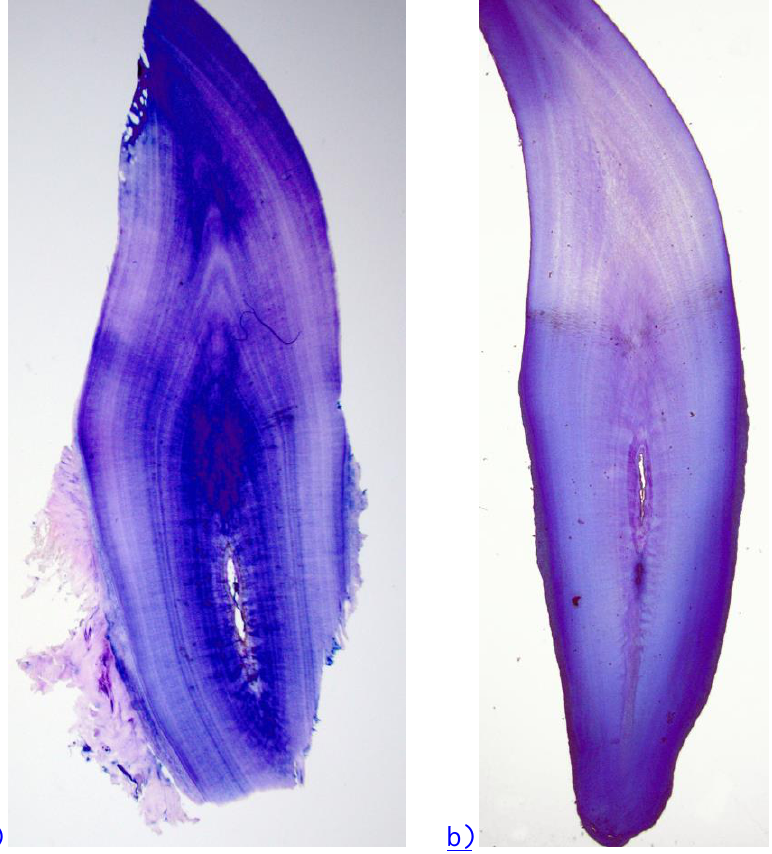
Fig. 3 . Abnormality surrounding the pulp cavity of Kelly ’s teeth that occurred to varying degrees in the seven processed teeth samples; (a) tooth A, decalcified using 10% formic acid, sectioned at 25 µ using a cryostat and stained with toluidine blue (x12.5 magnification); (b) tooth B, decalcified using 10% EDTA, sectioned at 25 µ using a cryostat and stained with toluidine blue (x12.5